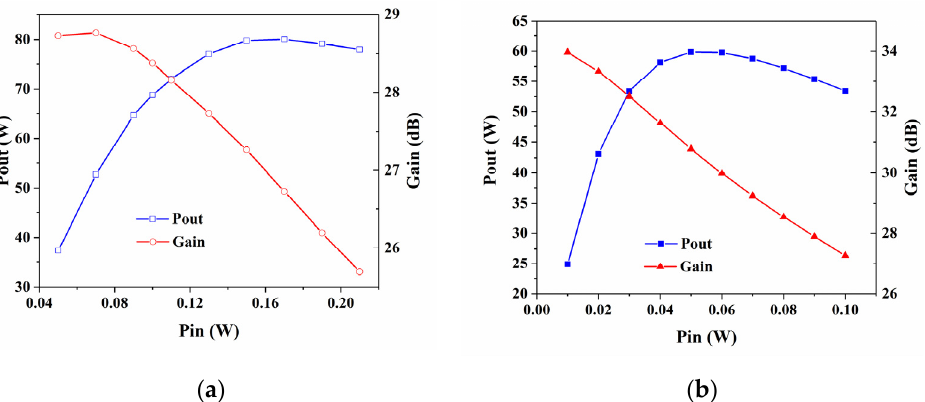
Figure 11. Variation of average output power and gain at 60 GHz with input power for the ( a ) DS- RSML SWS and ( b ) MDSRL-RSML SWS .